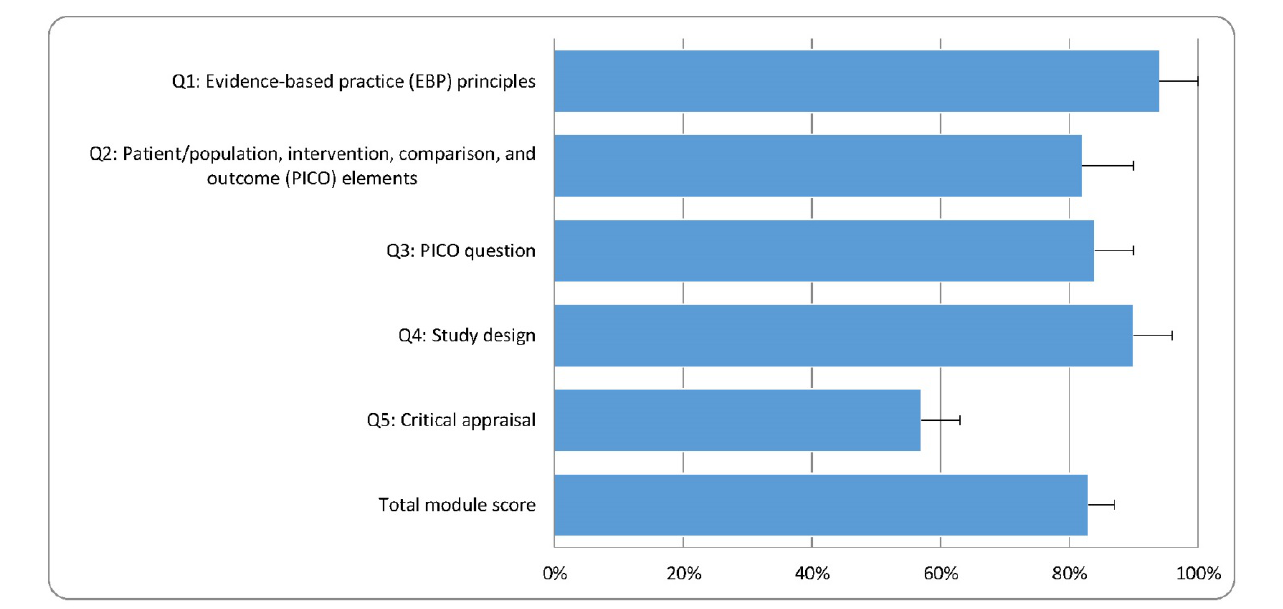
Figure 1 Total score and individual scores for module 1: “Introduction to Evidence-based Practice”*